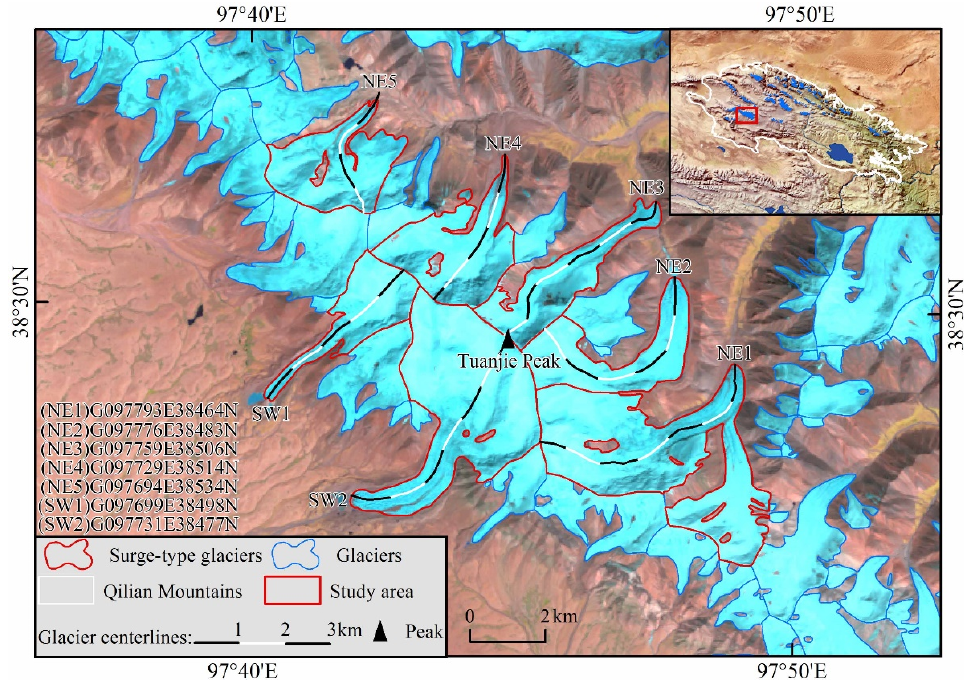
Figure 1. The distribution of STGs in the TJP. Flowlines shown here are used for velocity and elevation profiles. Black and white lines mark the distance from the terminus position in kilometers, plotted at 1 km intervals. Background image is from Landsat TM on 1 August 2006, projected on a WGS84 grid. The white border in the sub-picture indicates the range of the QLMs. We numbered each glacier by combining their orientation. NE and SW indicate the northeast slope and the southwest slope, respectively.